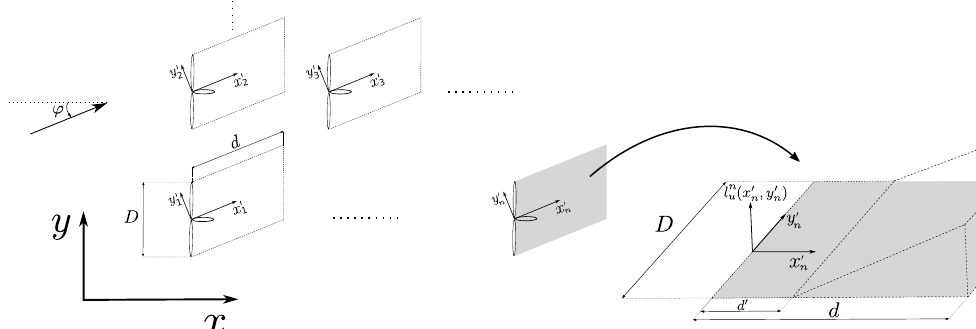
Figure 3. Schematic illustration of the mixing